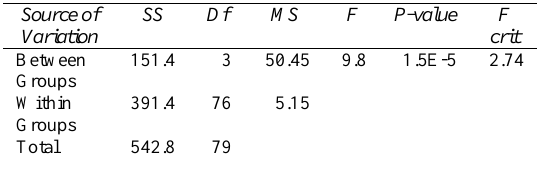
Table 3 ANOVA Test